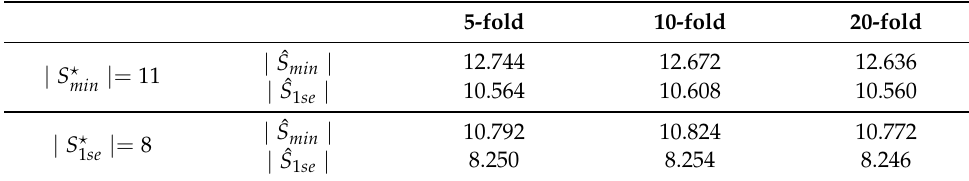
Table 5. Mean of selected model size | ˆ S | : Boston Housing Price.